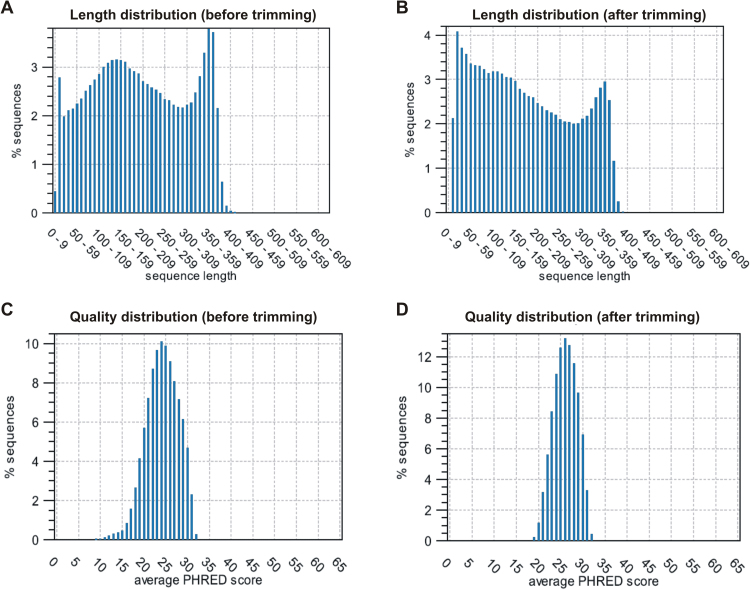
Histogram representing the (A) length distribution of the raw reads (before trimming). (B) Length distribution of the filtered reads (after trimming). (C) Phred quality score distribution of the raw reads (before trimming). (D) Phred quality score distribution of the filtered reads (after trimming).